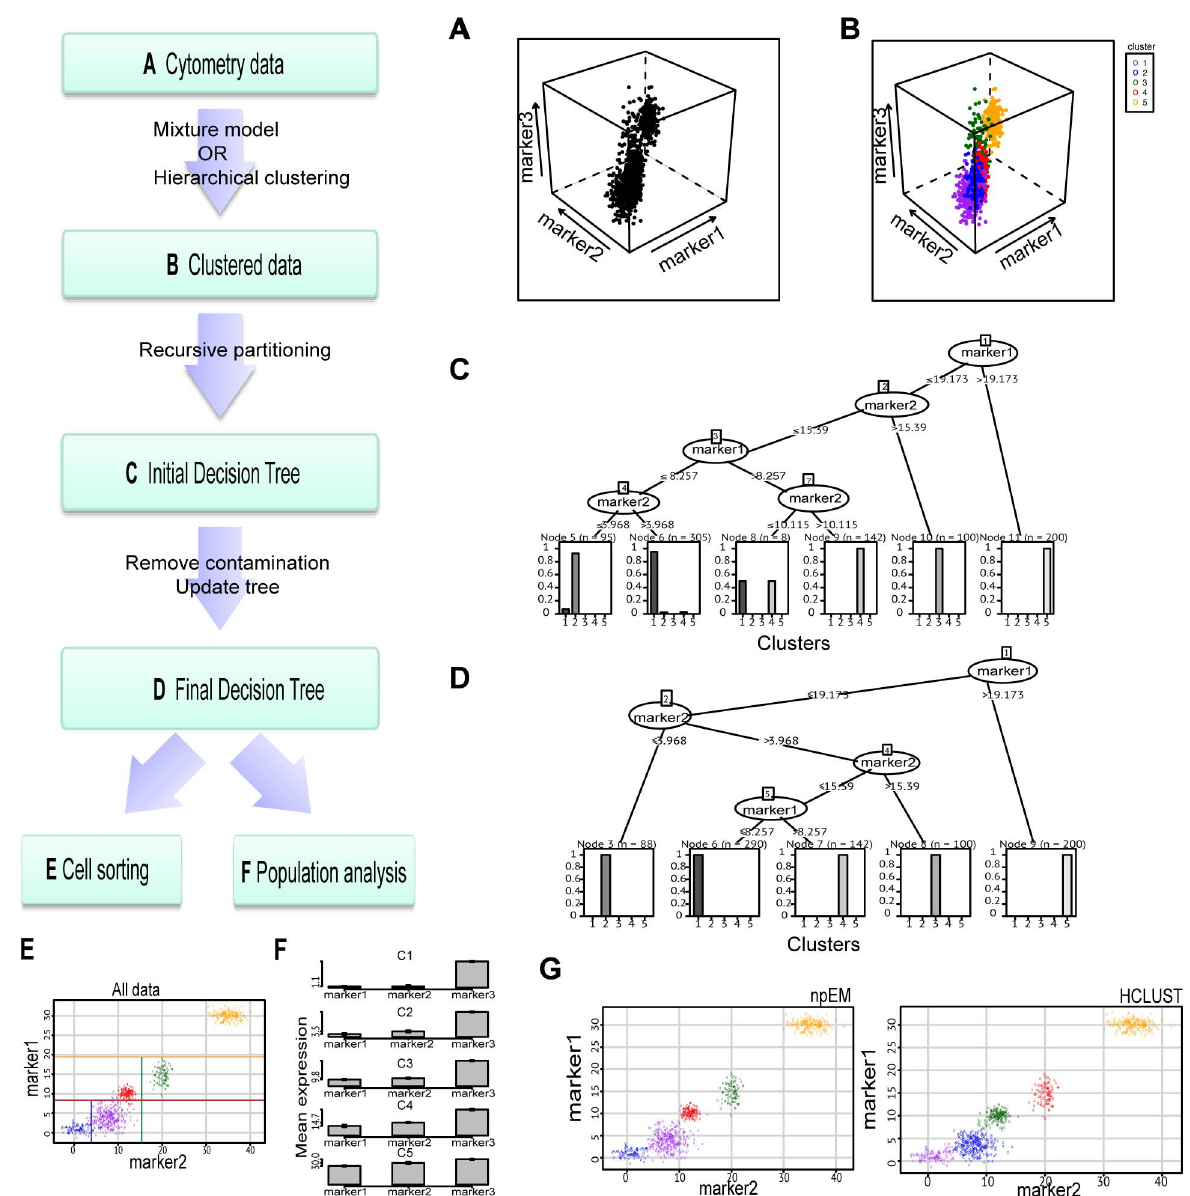
Figure 1. CCAST flowchart and analysis on a simulated dataset. A Cytometry data represented by 3D scatterplot of simulated FCM data showing the expression of 3 markers across all cells. B Clustering analysis produces five cell types color coded and denoted as Cell-types 1, 2, 3, 4 and 5. C Initial CCAST decision tree generated showing subpopulations at the leaf nodes. Nodes 9, 10 and 11 contain a single cell type and are considered as pure subpopulations. Nodes 5 6 and 8 contain a mixture of cell types. D Final CCAST decision tree obtained after filtering the data by removing contaminating cells in nodes with mixed cell-types. This tree can be used for cell sorting or data analysis. E 2D scatter plot of original (unfiltered) data showing the 5 clusters color coded and estimated cut-offs with corresponding color-coded thresholds for sorting the 5 cell state populations. Note that the subpopulations can be sorted using only Marker 1 and Marker 2 even though three markers were initially used to identify the cell types. F Bar plot the three markers in each subpopulation derived using the final CCAST tree on the filtered data. G 2D scatter plot of the filtered data derived from CCAST showing the analysis derived from hierarchical (right) versus npEM (left) clustering are similar.